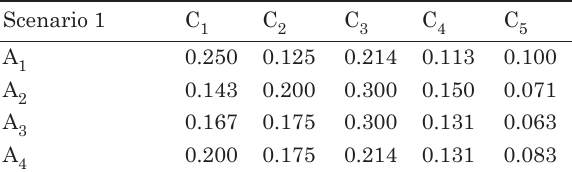
Table 8. Weighted and normalized decision-making matrix for the summarizing part (second scenario) Scenario 2 C 1